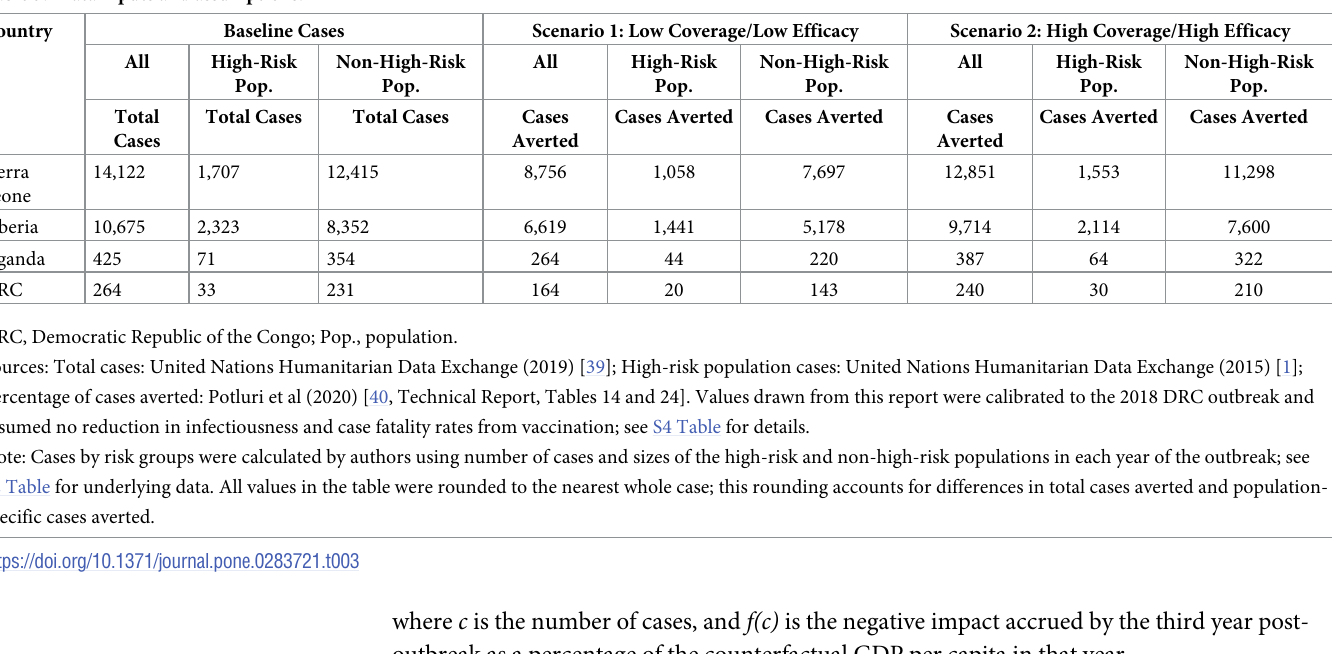
Table 3. Data inputs and